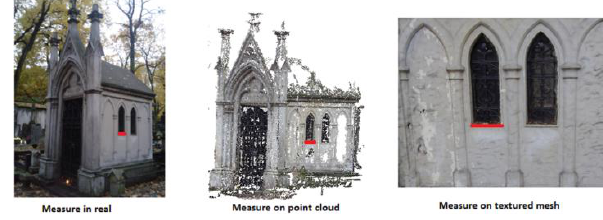
Figure 4. An example of precise accuracy